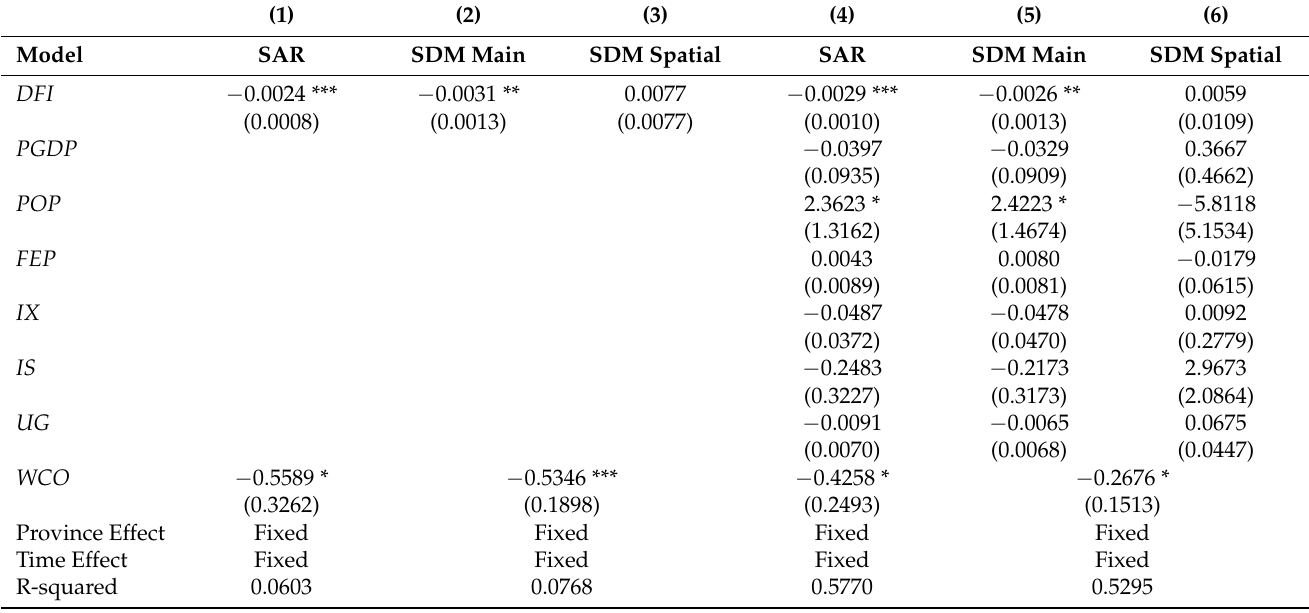
Table 3. Regression results of digital financial inclusion index on CO 2